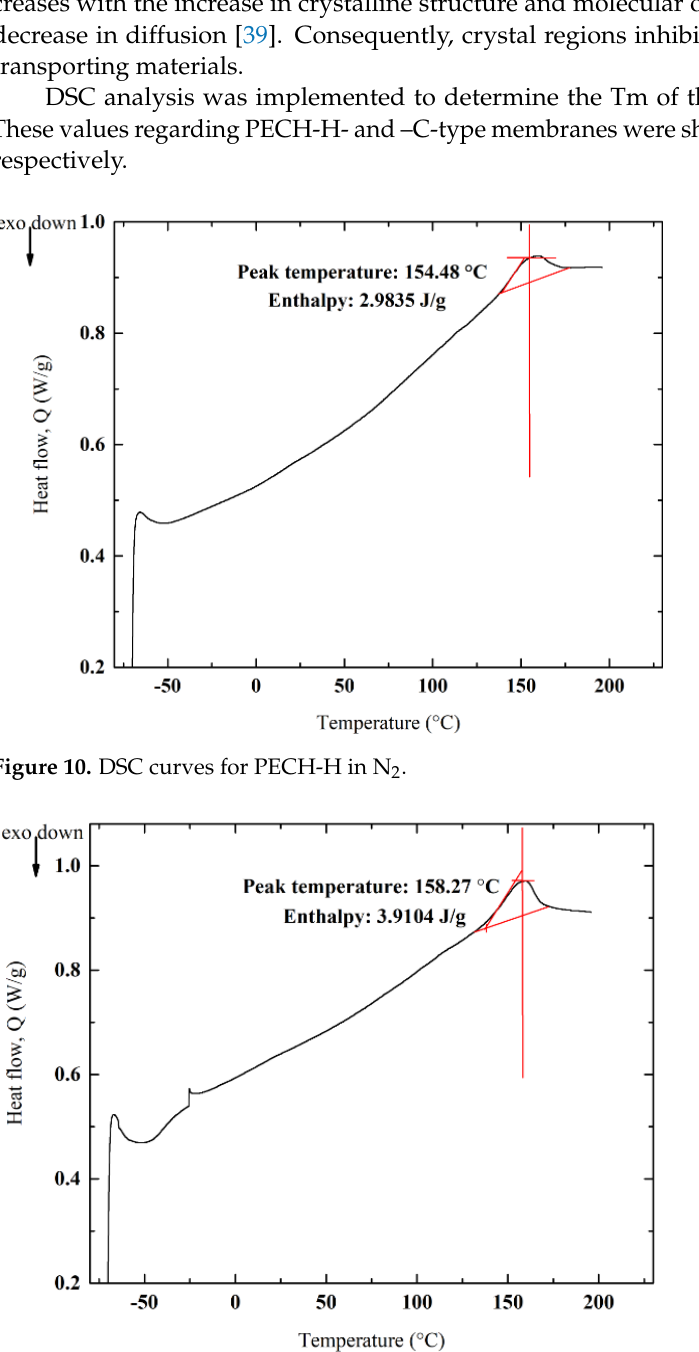
Figure 11. DSC curves for PECH-C in N 2